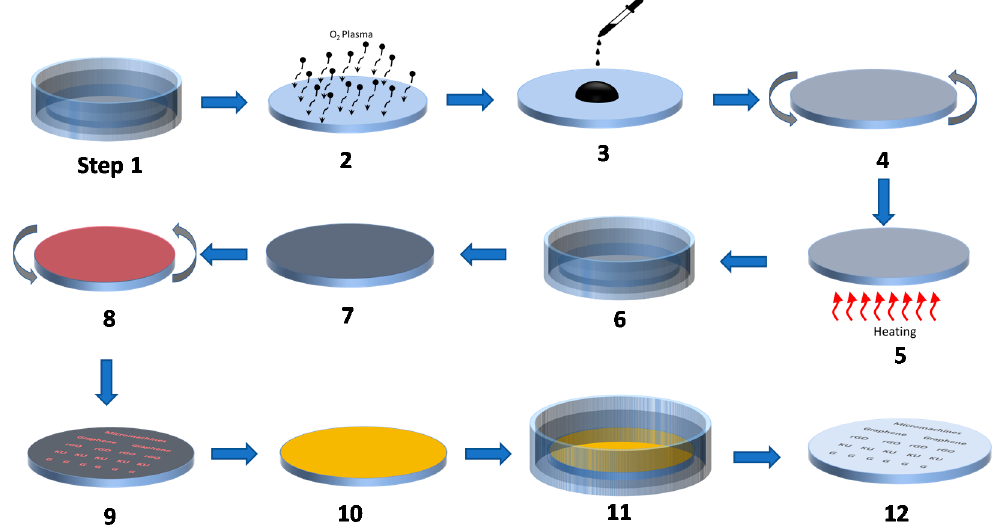
Figure 1. Schematic of the fabrication steps followed to achieve the proposed micro-pattern